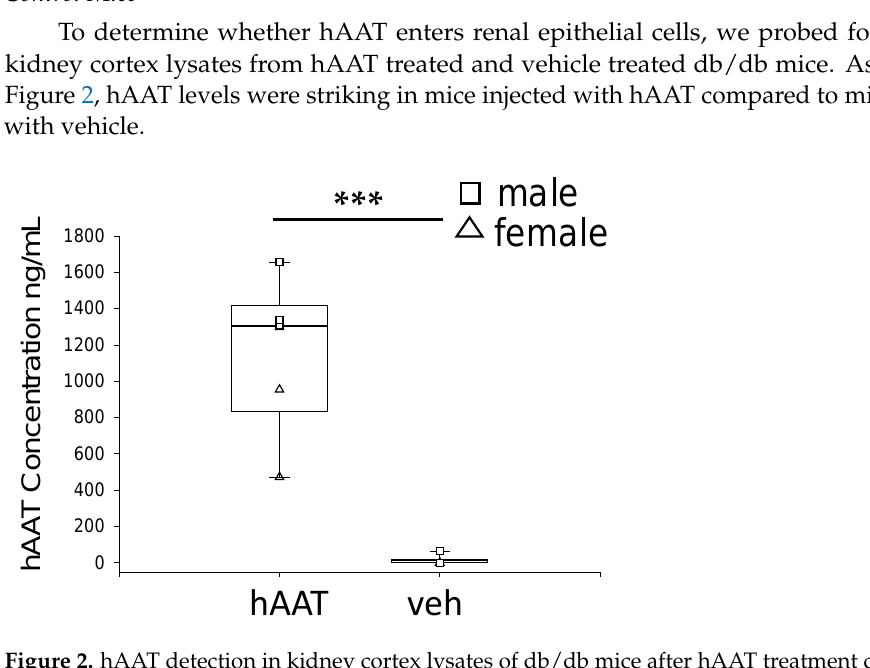
Figure 2. hAAT detection in kidney cortex lysates of db/db mice after hAAT treatment compared to vehicle treatment. The concentration (ng/mL) of hAAT in hypertensive diabetic db/db mice treated with hAAT or vehicle was measured by ELISA. The total volume of kidney lysate used was 15 µ L. *** p <